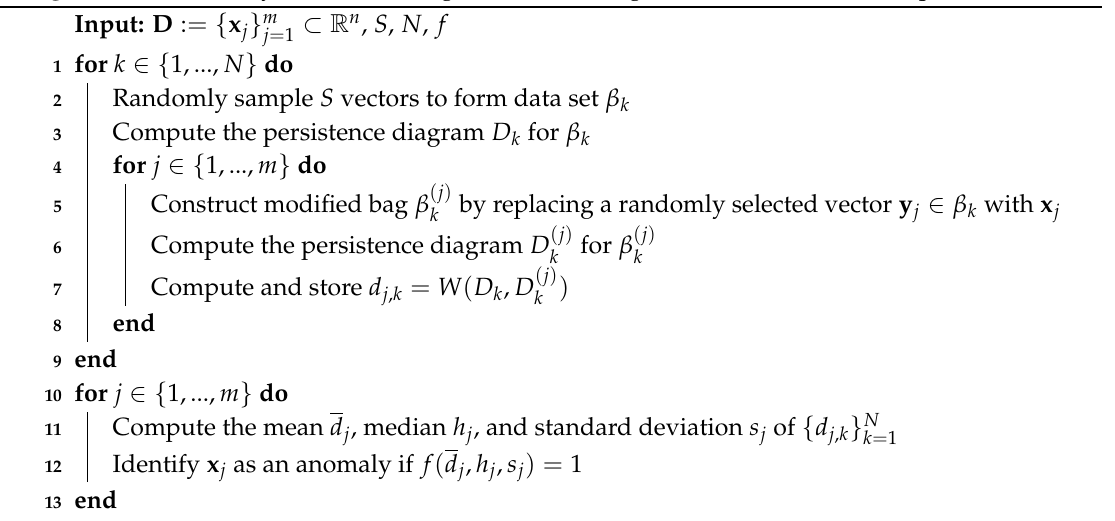
Algorithm 1: Anomaly Detection using Persistence Diagrams of Random